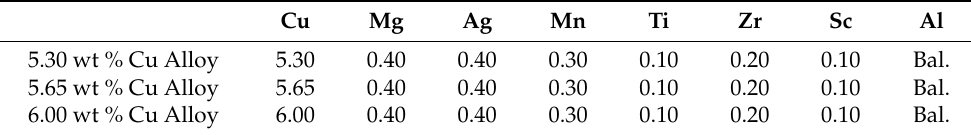
Table 1. Chemical compositions of the present alloys (in wt